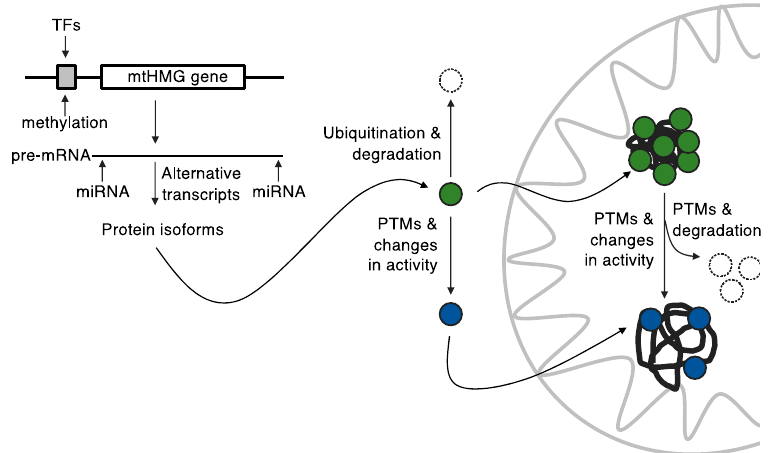
Figure 4. Possible means of regulating mtHMG proteins. The levels of mtHMG proteins can be controlled at the level of transcription by employing specific transcription factors (TFs) as well as by epigenetic markers such as DNA methylation. In the case of TFAM, alternative splicing generates isoforms differing in the number of functional HMG-boxes. Prior to or following their import into mitochondria, mtHMG proteins can undergo various post-translational modifications (PTMs) that can affect their susceptibility to proteolytic degradation, propensity to interact with protein partners (not shown), and DNA-binding activity. As a result, mitochondrial DNA (mtDNA) can be either tightly compacted or more relaxed and thus more accessible to the components of the replication, transcription, recombination, and translation machineries. See text for more details.